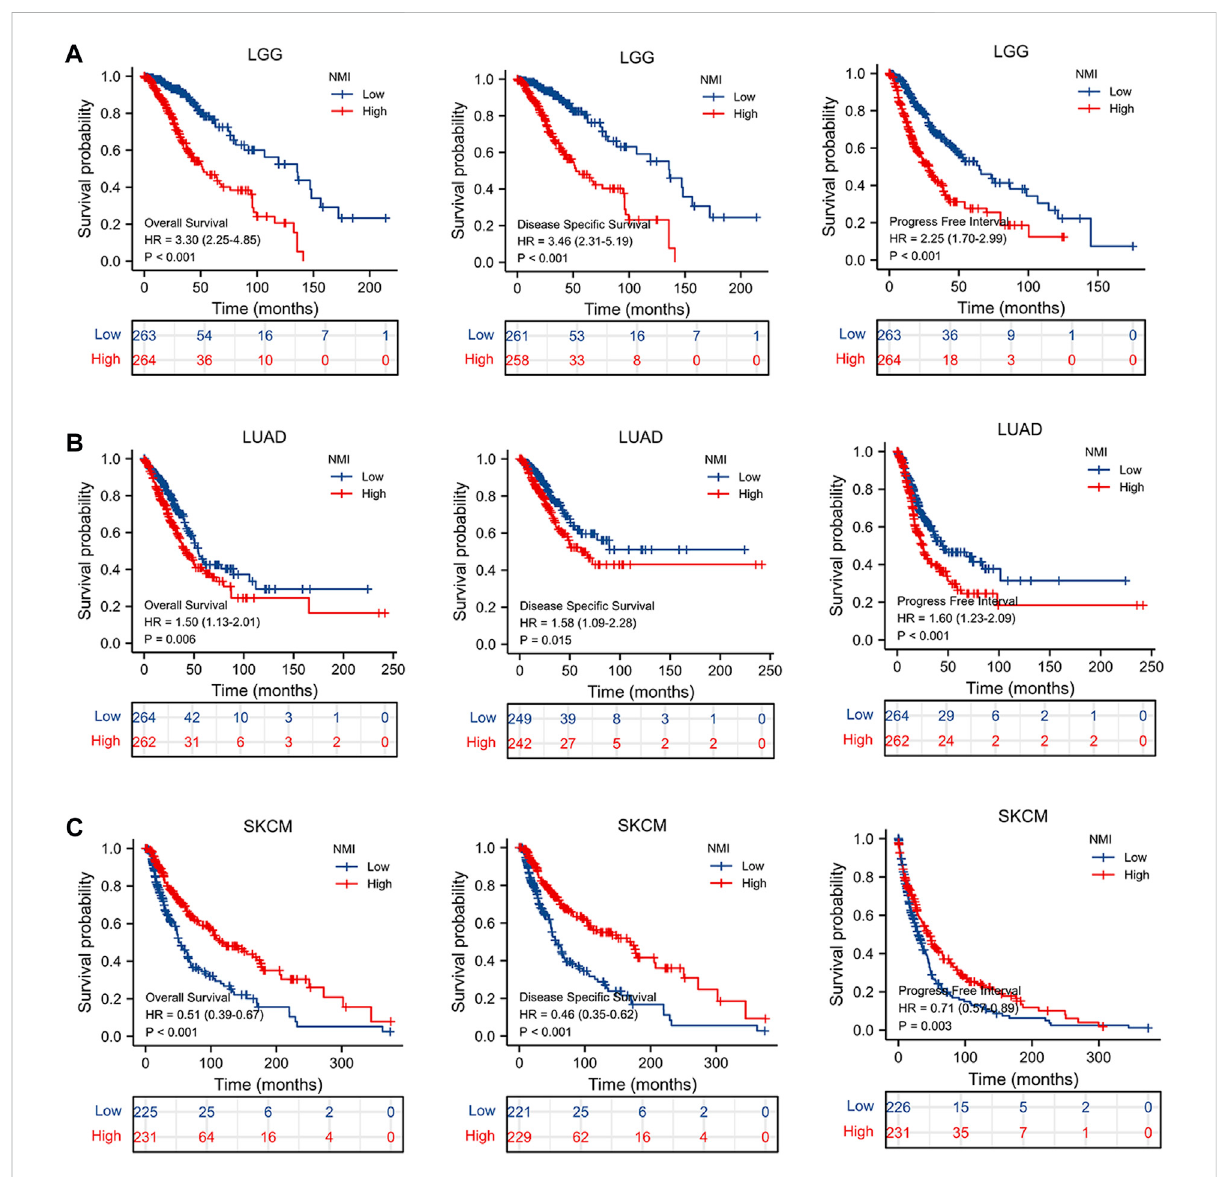
FIGURE 6 The relationship between NMI and OS, DSS and PFI in tumor patients. (A) LGG, (B) LUAD, and (C)